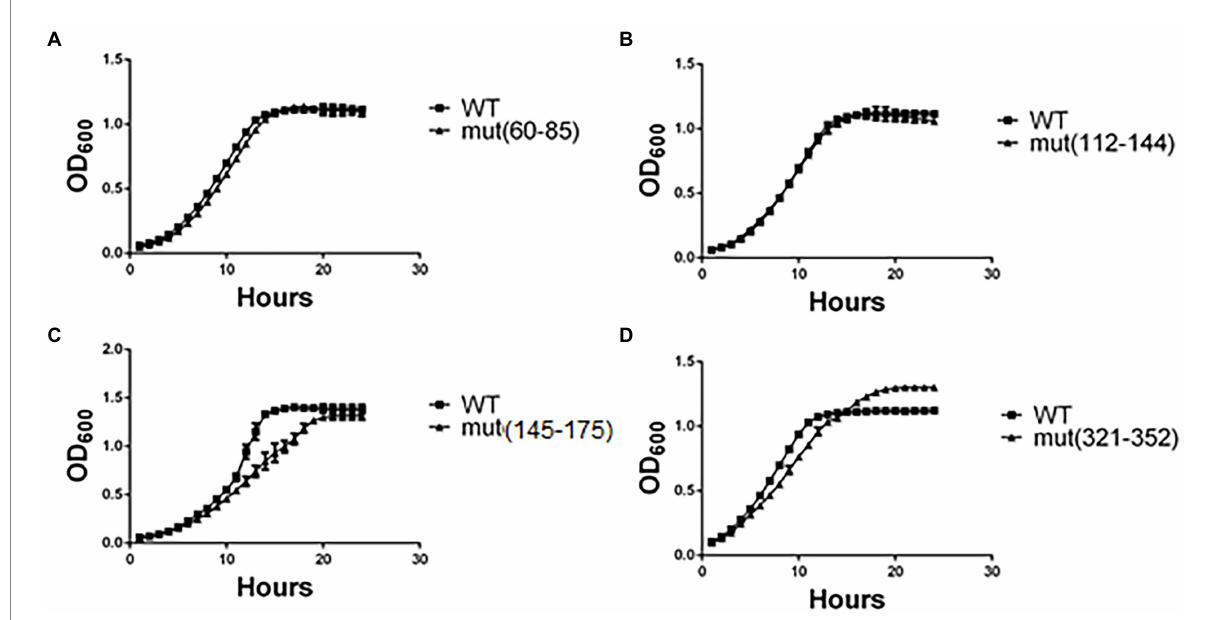
FIGURE 2 Yeast growth in minimal medium is altered in certain strains harboring synonymous mutations. Yeasts were grown in minimal medium (EMM2) under standard conditions for 24 h at 30 ° C, and OD 600 recorded each hour. Readings of (A) mut(60–85), (B) mut(112–142), (C) mut(145–175), and (D) mut(321–352) were plotted and compared to the control (WT). These results are representative of three independent experiments.